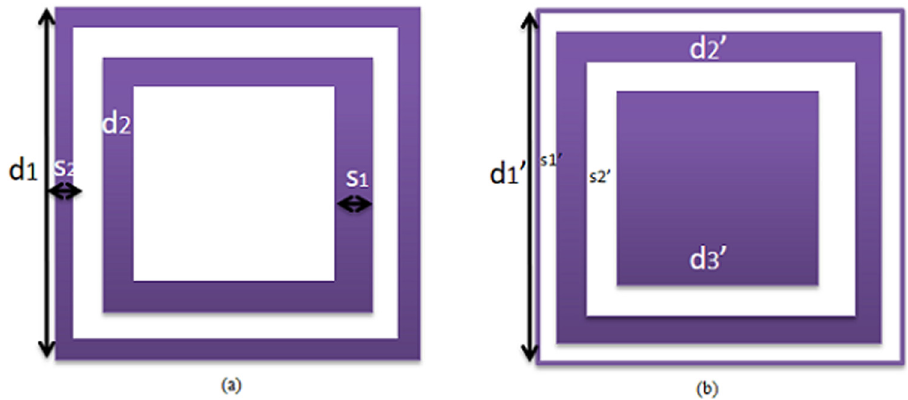
Figure 4: Unit cell con fi gurations of ( a ) DSLFSS and ( b )